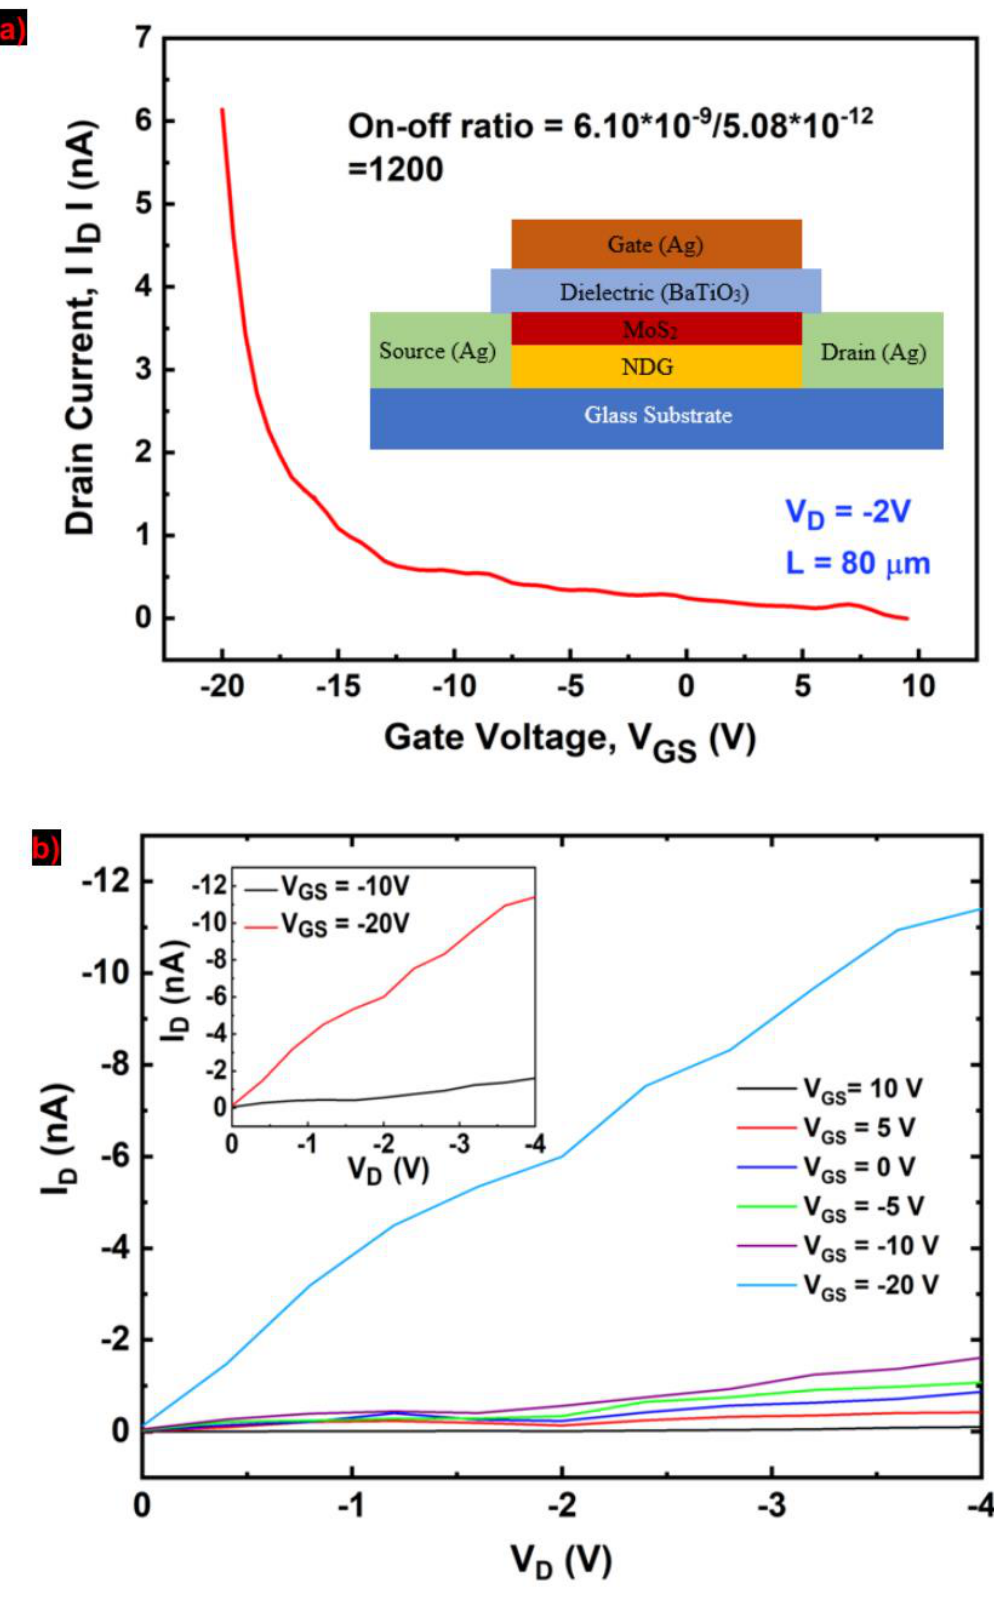
Figure6. ( a )TransfercurveoftheMoS 2 –NDGtransistorshownintheinset, and( b )outputcharacteristics Figure 6. ( a ) Transfer curve of the MoS 2 –NDG transistor shown in the inset, and ( b ) output of the same characteristics of the same device.